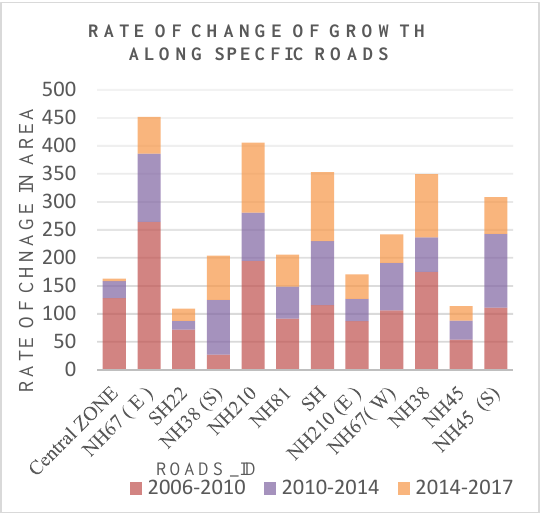
Figure5. Rate of change of urban area along the roads from